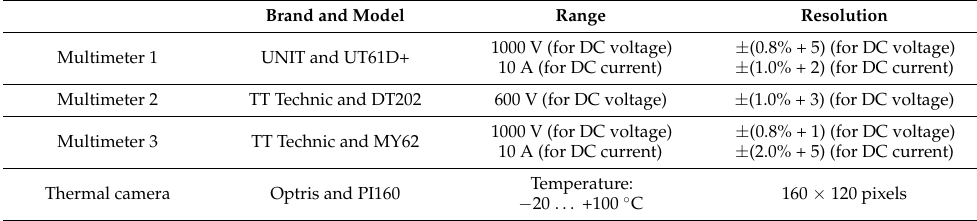
Table 3. Models and technical specifications of all devices.